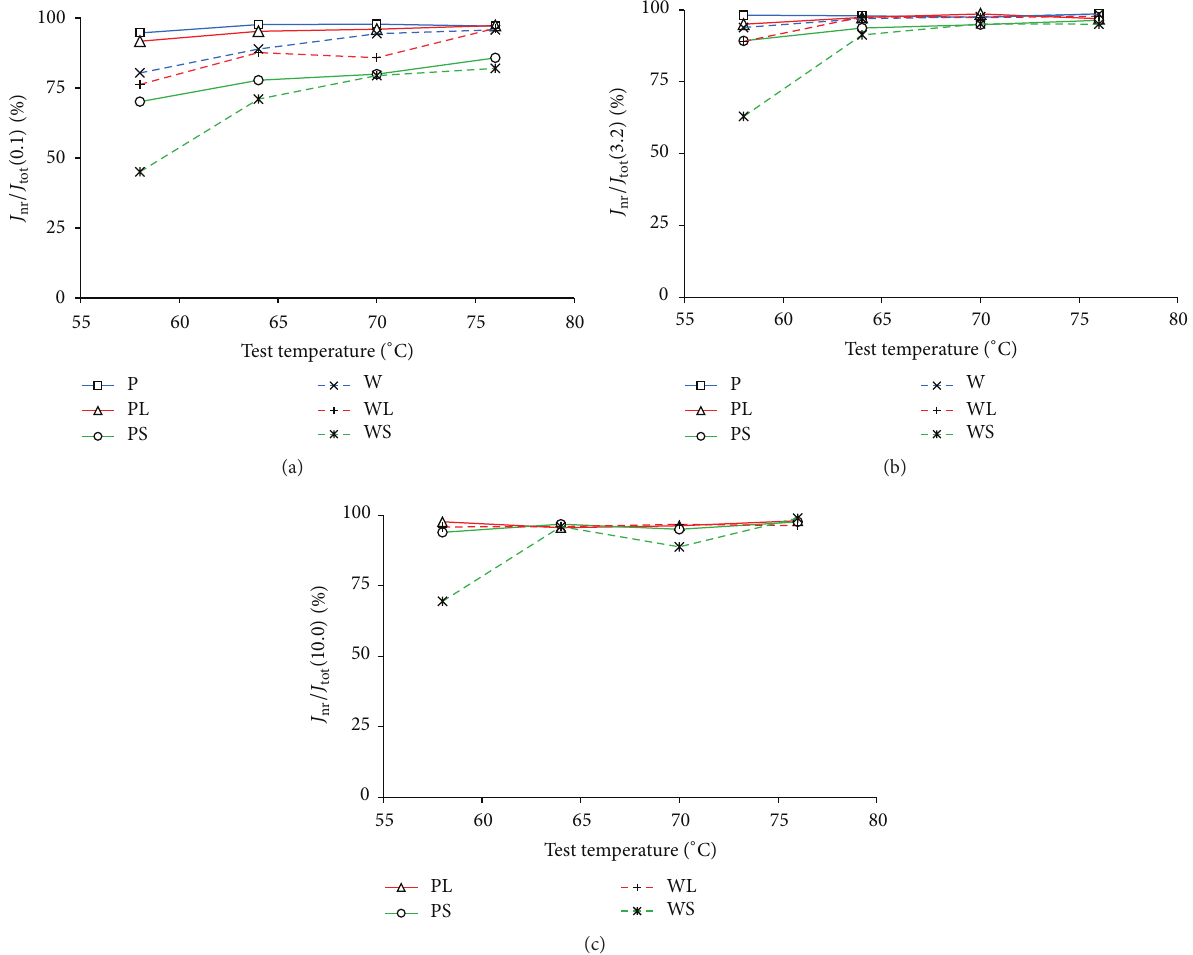
Figure 10: 𝐽 nr / 𝐽 tot at stress level of 0.1 (a), 3.2 (b), and 10.0 (c)